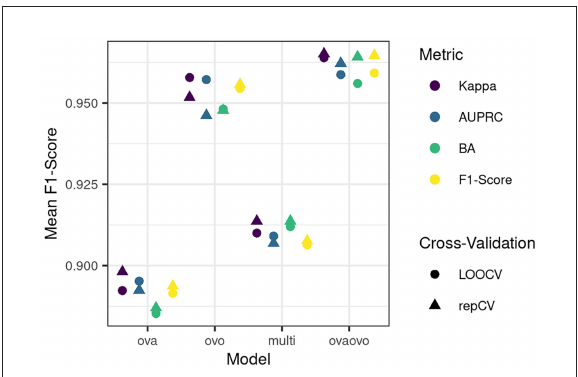
FIGURE4 Performance of different models on the training data set. The mean F1-score was calculated as the mean of F1-scores across profiles 1–6 and 8–13. Metrics and cross-validation schemes can be distinguished by color and shape, respectively. BA refers to balanced accuracy. LOOCV refers to leave-one-out cross-validation; repCV to repeated 10-fold cross-validation.